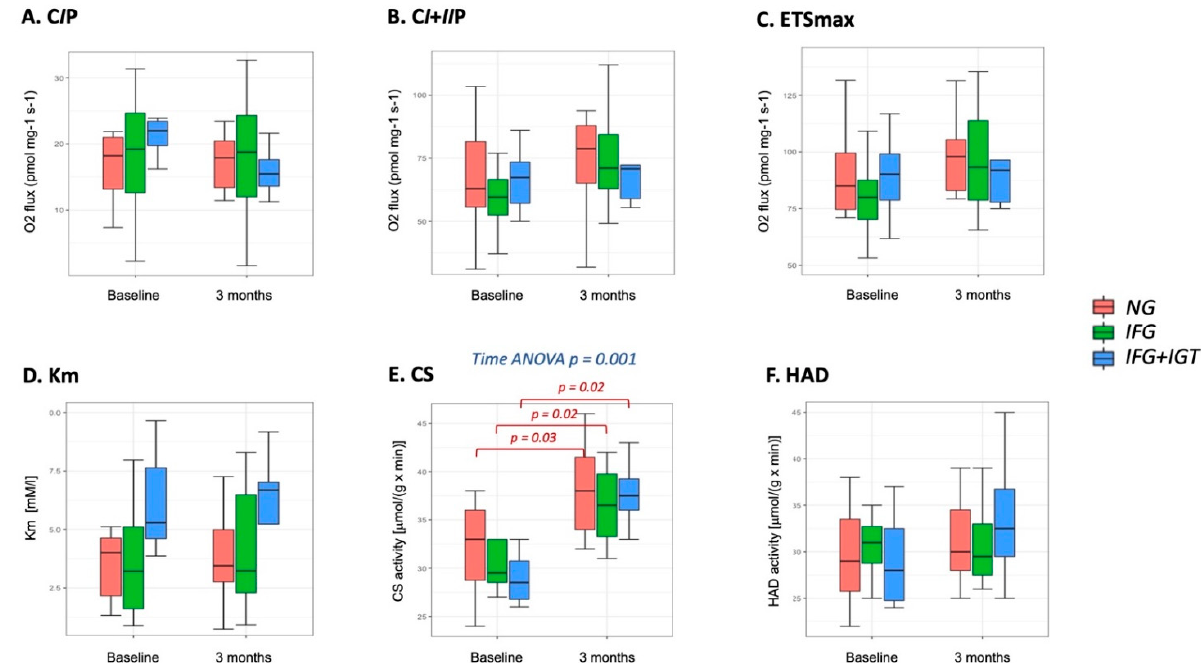
Figure 2. MUSCLE mitochondrial content (via citrate synthase activity) and mass-specific respiratory capacity parameters in patients with Normoglycemia (NG), isolated Impaired Fasting Glucose (IFG) and Impaired Fasting Glucose and Impaired Glucose Tolerance (IFG + IGT), before and after 3 months of exercise intervention. ( A ). Complex I-linked OXPHOS capacity (CIP); ( B ). Maximal complex I + II-linked OXPHOS capacity (CI + IIP), ( C ). maximal capacity of the electron transfer system (ETSmax); ( D ). Km for succinate titration, ( E ). Citrate Synthase (CS) activity. ( F ). β -hydroxy-acyl-CoA dehydrogenase (HAD) activity. Square root transformation was performed to calculate model-based means and 95% CI.